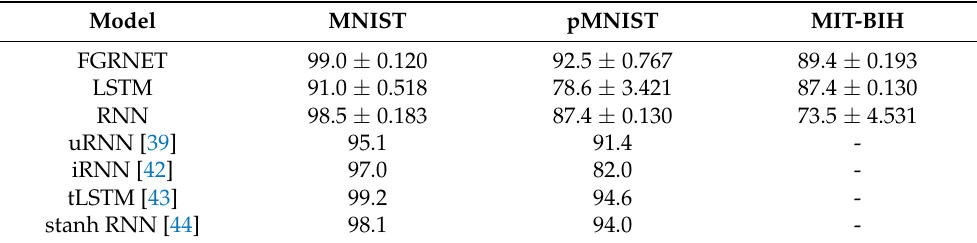
Table 2. Comparison of accuracy of training results of different networks against dataset (%).